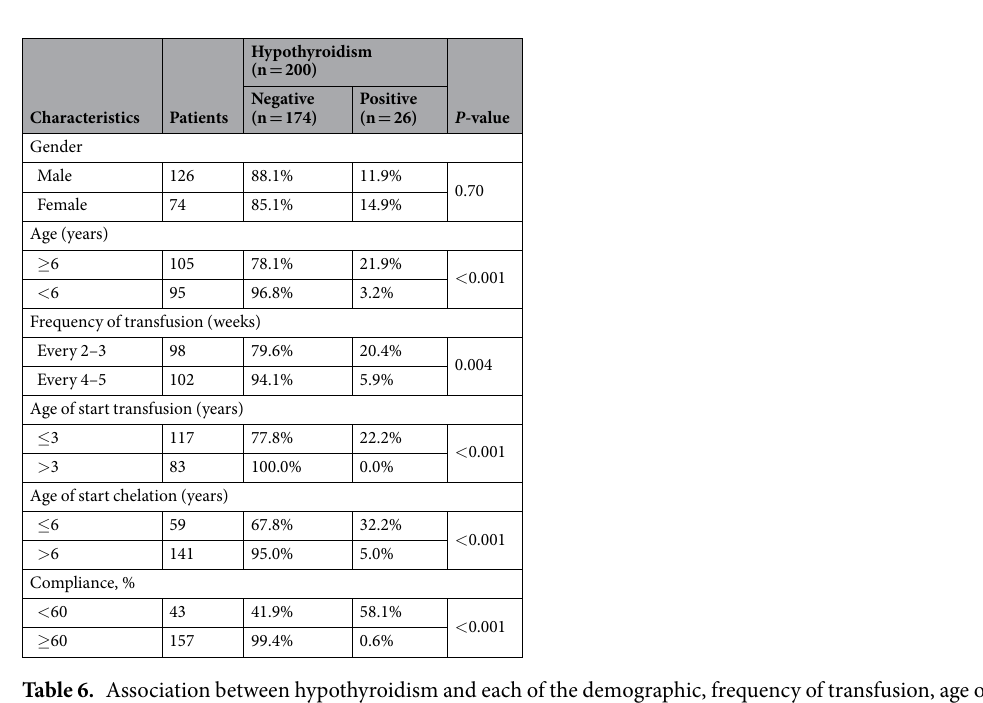
yrodism represent the most common endocrinopathies in thalassemic patients 10 . In this study, we evaluates the impact of genotype on endocrinal complications of Children with Alpha- thalassemia in China and demonstrates that hypogonadism is the most frequent endocrine complication in α -thalassemia (84.0%), followed by growth retardation (68.5%) and hypoparathyroidism (14.5%). Our survey showed that the MCV levels in group ( α CS α /–SEA) were higher than those in group (- α 3.7/– SEA) and group (- α 4.2/–SEA)( P < 0.001, P < 0.001, respectively), there were no significant differences in RBC,